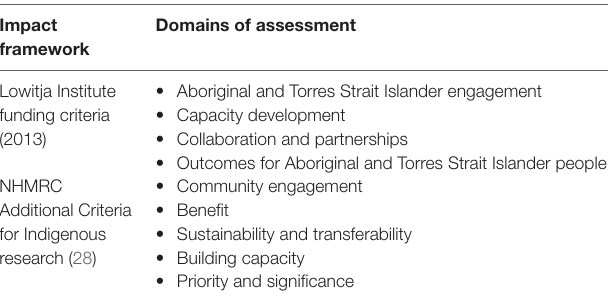
TaBle 1 | selected research impact